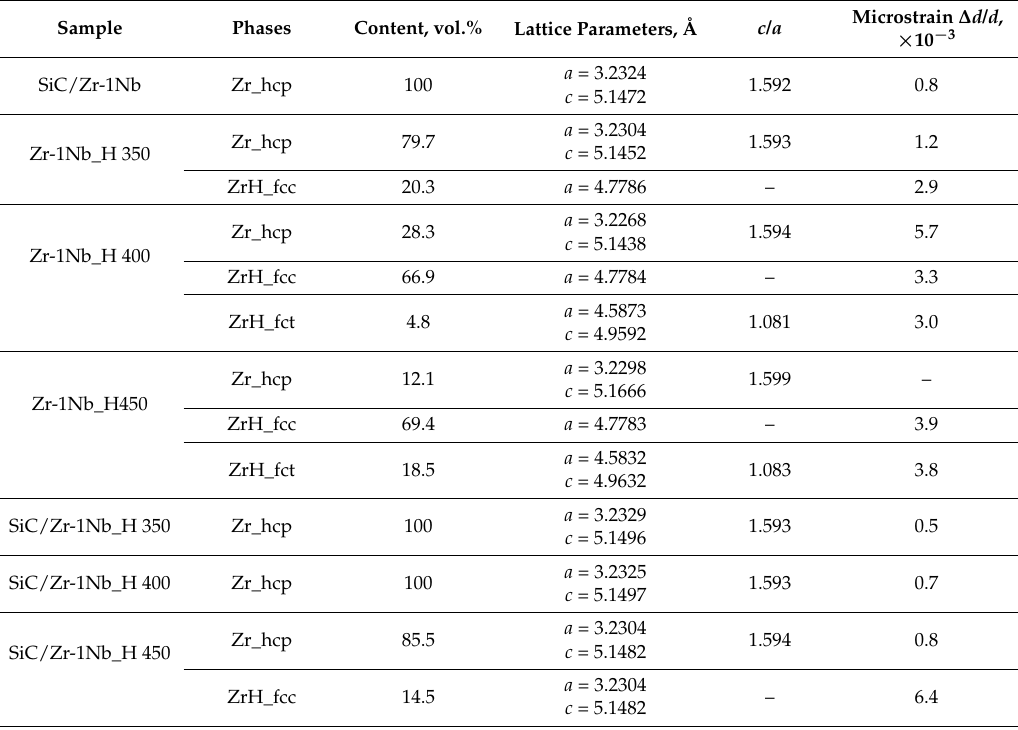
Figure 5. XRD patterns of hydrogenated Zr-1Nb ( a ) and SiC-coated Zr-1Nb alloy ( b ). Table 2. X-ray diffraction